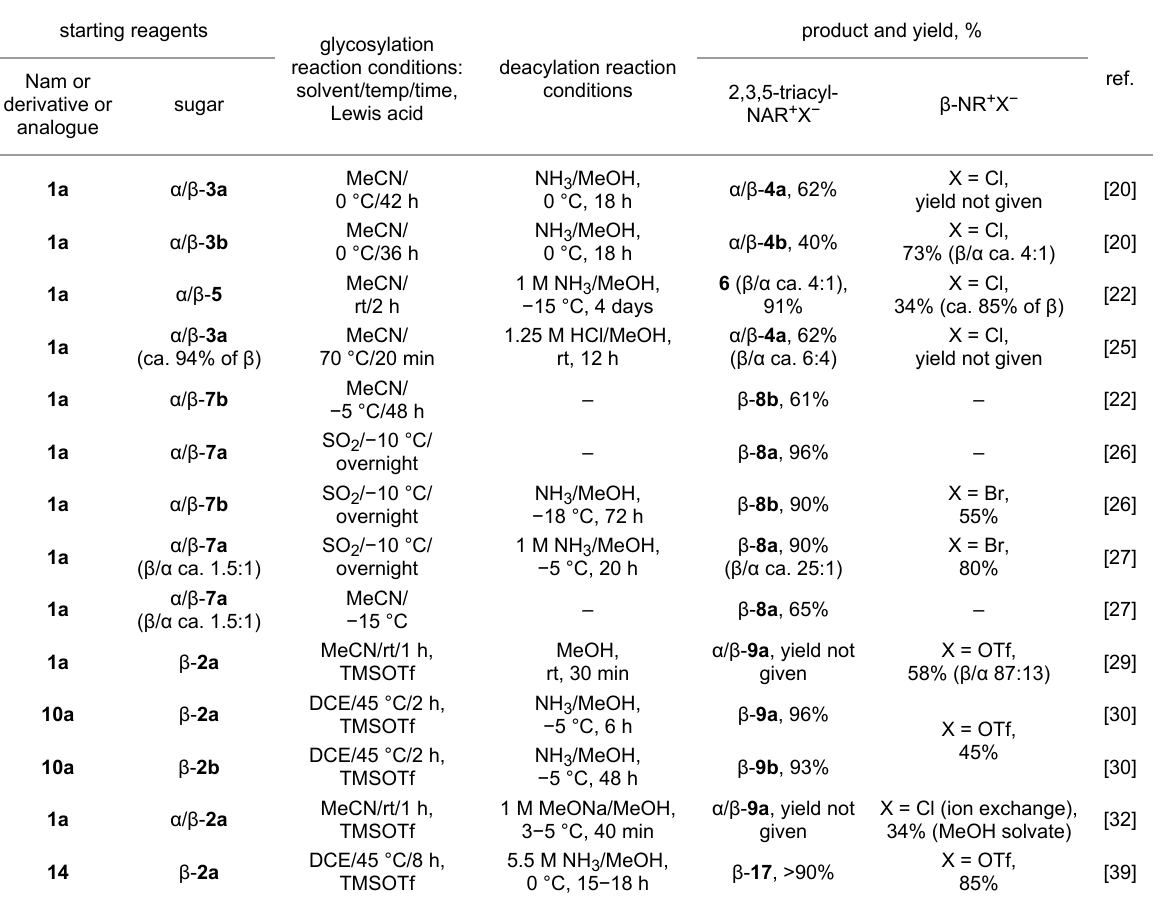
product and yield,